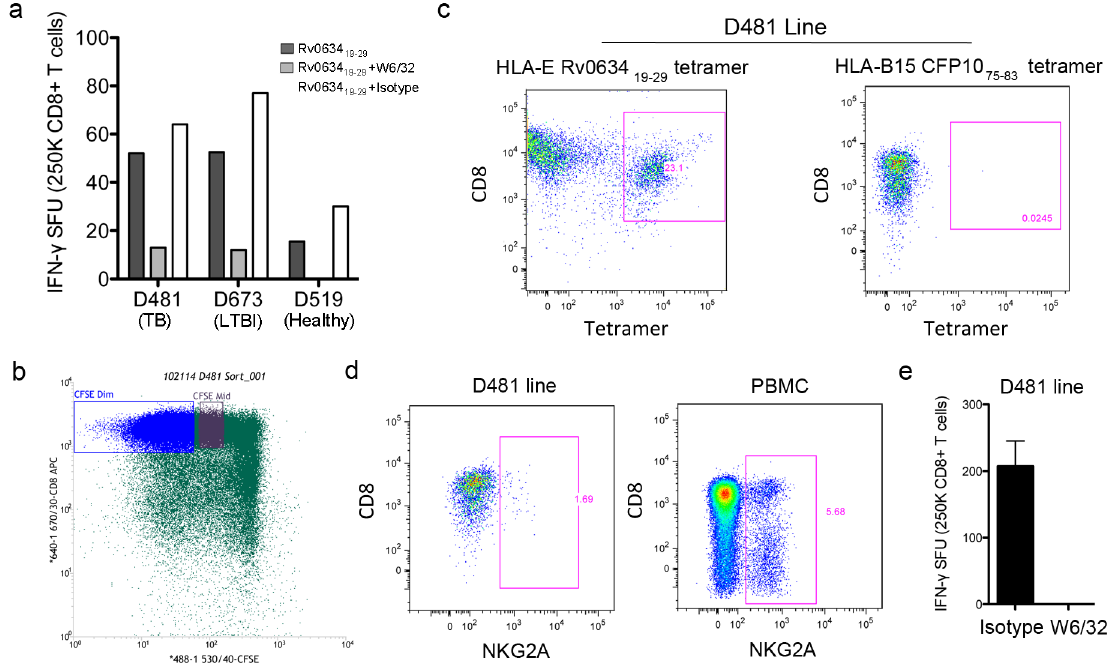
Fig 6. The CD8 + T cell response to Rv0634A 19-29 is restrictedby HLA-E. A) A549 cells were pulsedwith the Rv0634 19-29 peptideand used as antigenpresenting cells in an ELISPOT assay with IFN- γ productionby CD8 + T cells from mismatched donors as a readout. B-D) D481 CFSE-labeledCD8+ T cells were isolated and culturedwith Rv0634A 19-29 peptide-pulsed autologousmacrophages and DC. CFSE-dim cells were sorted and stainedwith the Rv0634A 19-29 HLA-E tetramer and antibodiesagainst CD3 and CD8. As a control, the D481 line was also stained with a non-HLA-E tetramer (C), or with anti- NKG2A (D) do demonstrate that the tetramer staining is specific. Whole PBMC were stained with the anti-NKG2A antibody as a positive control. E) The mismatched A549 cell line was pulsedwith the Rv0634A 19-29 peptideand used as antigenpresenting cells with D481 CD8 + T cell line.